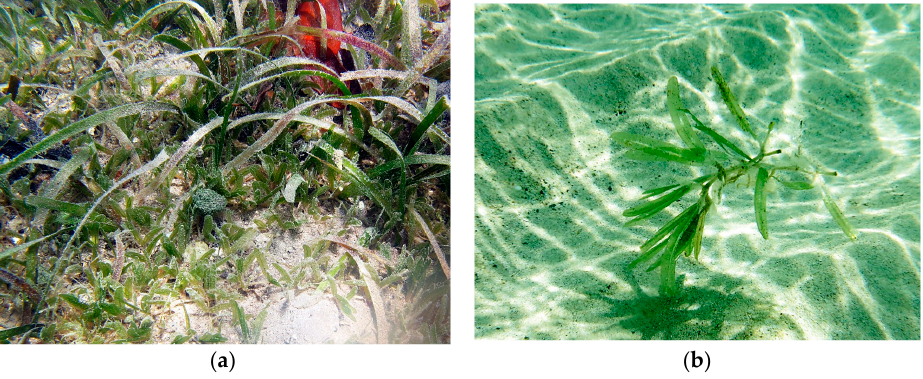
Figure 8. ( a ) The invasive seagrass Halophila stipulacea growing with the native seagrass Thalassia testudinum ; ( b ) The invasive seagrass Halophila stipulacea floats with its roots and rhizomes attached. 1.4. Sponges About 60 species of sponges grow in the mangrove-lined bays within Hurricane Hole [24].